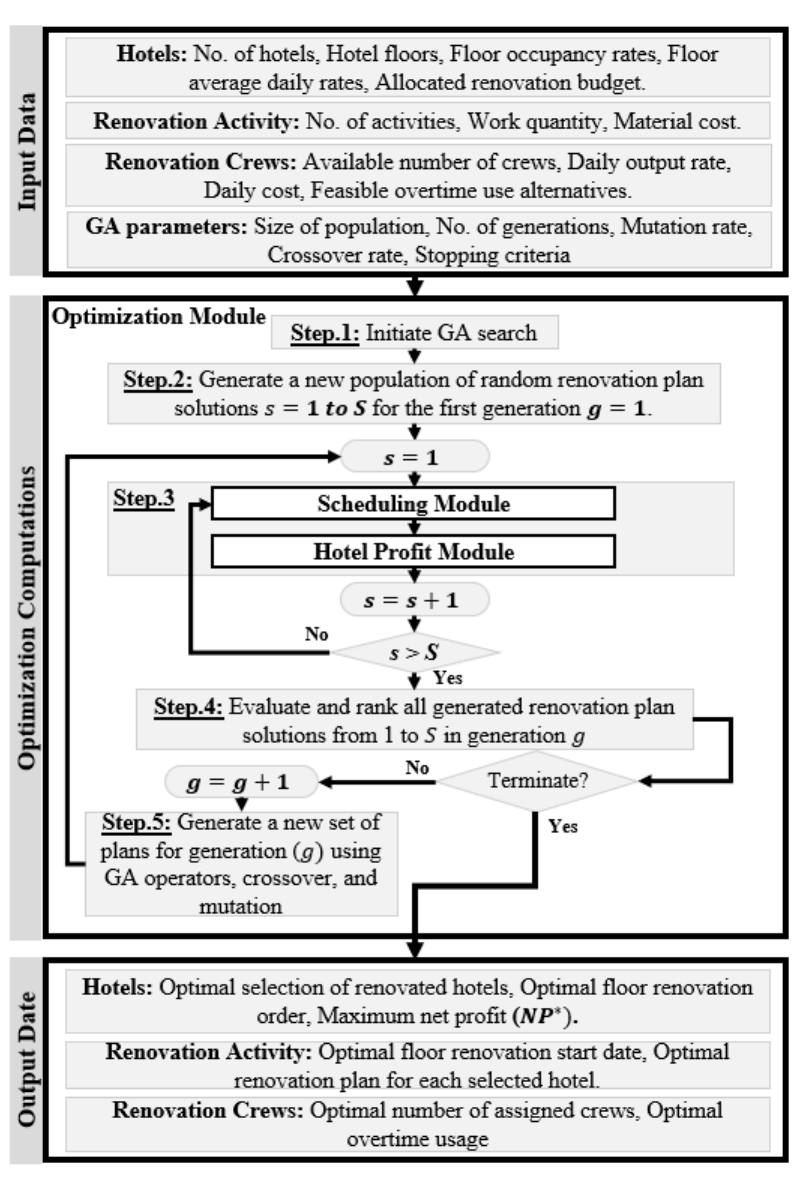
Figure 2. Model development modules.